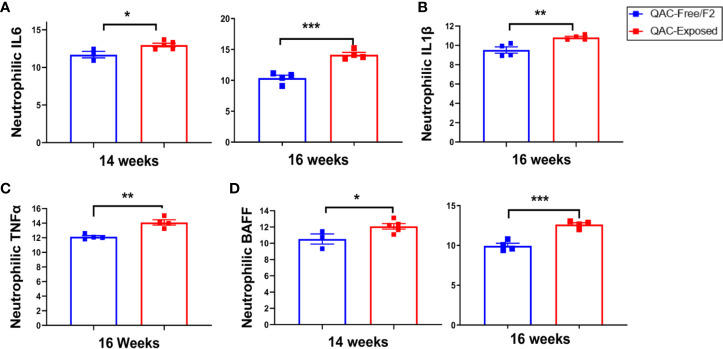
Pro-inflammatory neutrophilic phenotype with ambient exposure to QACs. Neutrophils were enriched from the bone marrow and relative transcript levels of (A) IL-6, (B) IL-1β, (C) TNFα, and (D) BAFF are shown. Data from the 1st experimental setting are shown as mean ± SEM. *P < 0.05, **P < 0.01, ***P < 0.001.